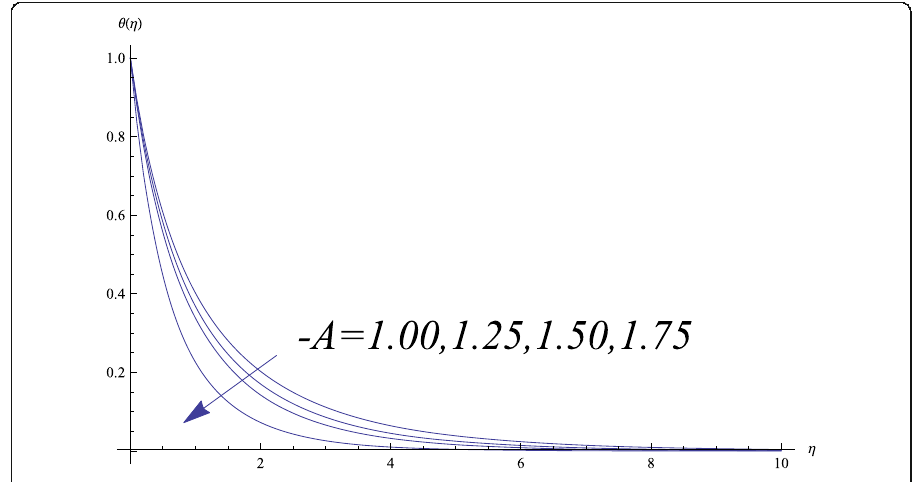
Fig. 5 Variation of fluid temperature with A , for Pr = 0.7, N R = 1, U 0 = 1, f 0 = −